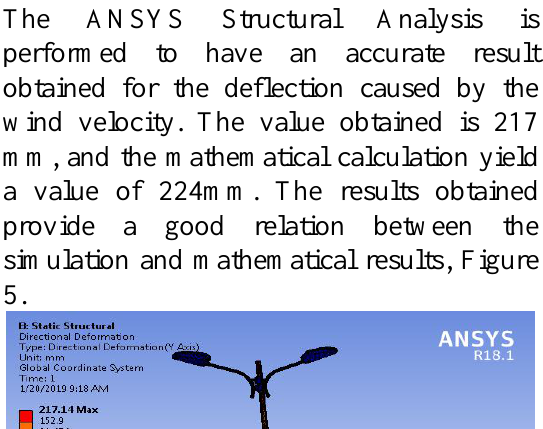
Fig. 4. FSI Window in Ansys Fluent